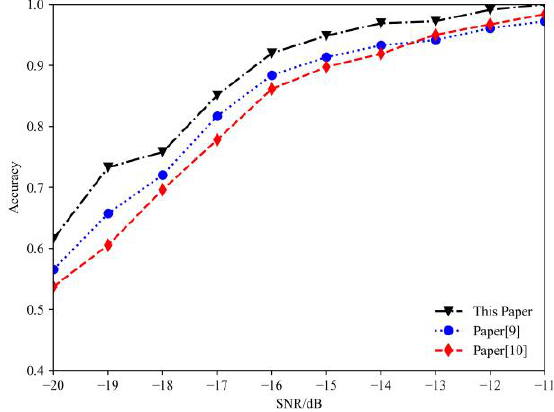
Fig. 3. Comparison of sorting results of different algorithms.